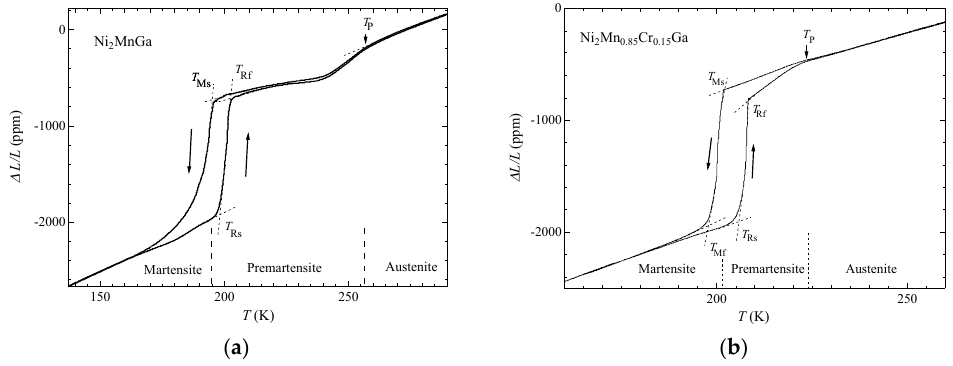
Figure 1. Temperature dependence of the linear strain ∆ L / L in the ( a ) x = 0.00 alloy; and ( b ) x = 0.15 alloy. The quantity T Rs is the temperature where the reverse ‐ martensitic transition starts; T Rf is the temperature where the reverse ‐ martensitic transition ends; T Ms is the temperature where the martensitic transition starts; and T Mf is the temperature where the martensitic transition ends. The dotted lines are intended to guide the eye.